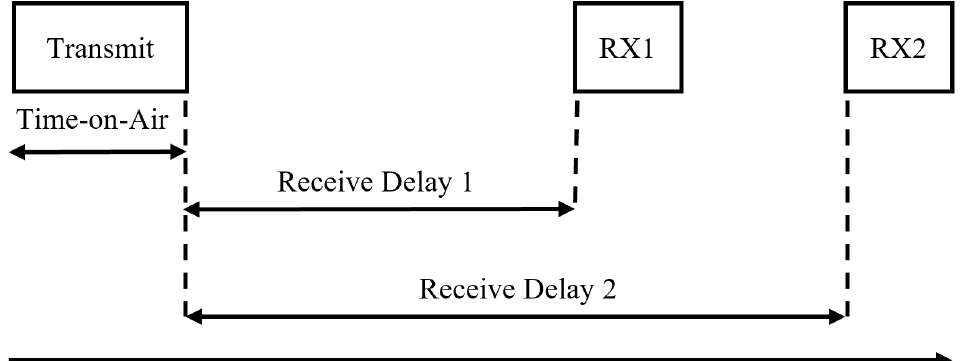
Figure 2. Receive windows in Class